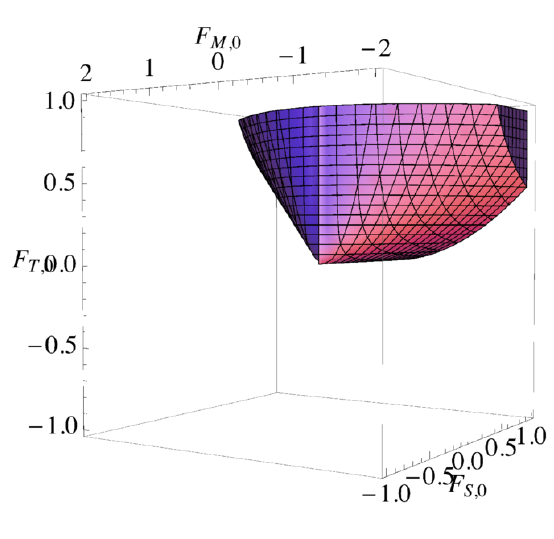
Figure 9 . In a subspace spanned by three coe(cid:14)cients, F S; 0 , F M; 0 and F T; 0 , allowed parameter space is described by a